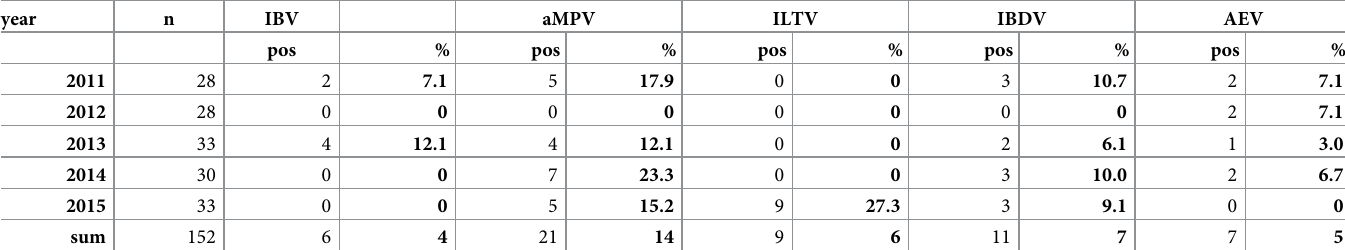
Table 3. Number and percentage of serum samples tested positive for antibodies against IBV, aMPV, ILTV, IBDV and AEV during spring sampling. Only trapped pheasants were